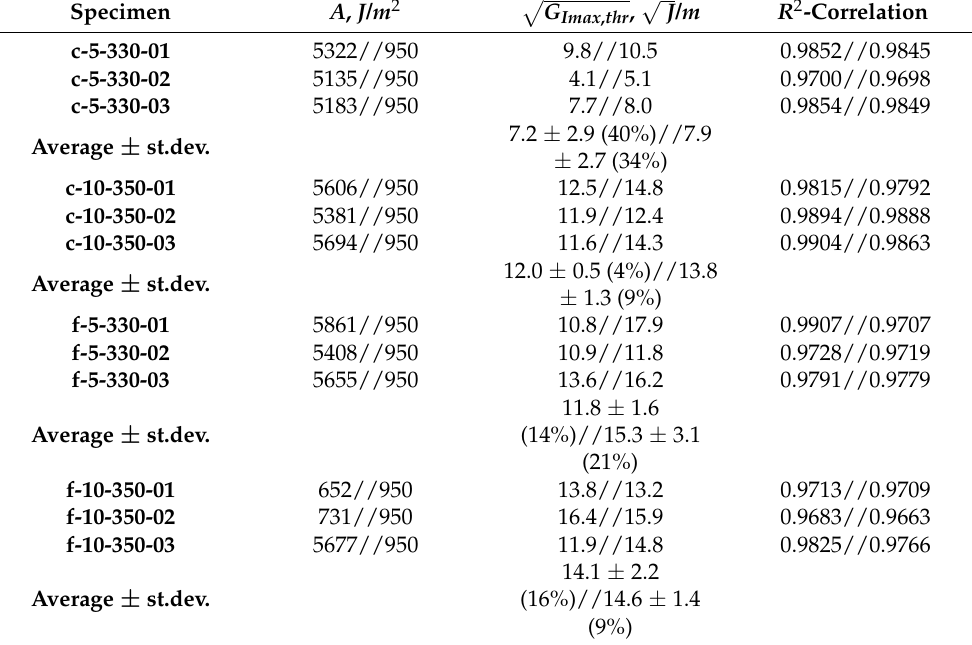
(cid:112) G Imax , thr which yield the highest R 2 -correlation of the linear fits of the fatigue data Table 6. A and using the modified Hartman-Schijve equation where ( A was varied// A was kept constant). Specimen A , J / m 2